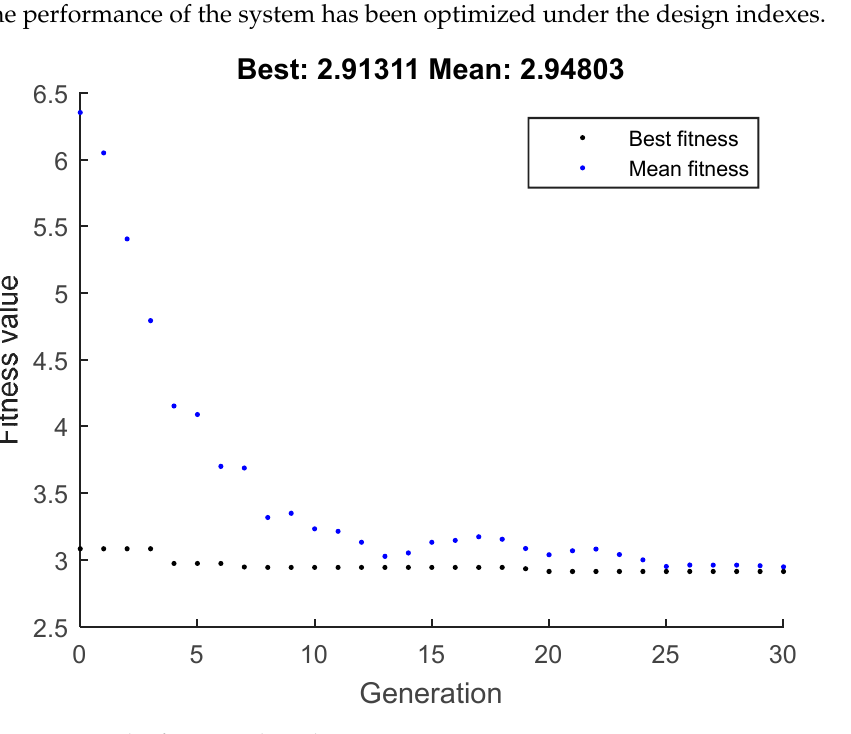
Figure 5. Result of genetic algorithm.